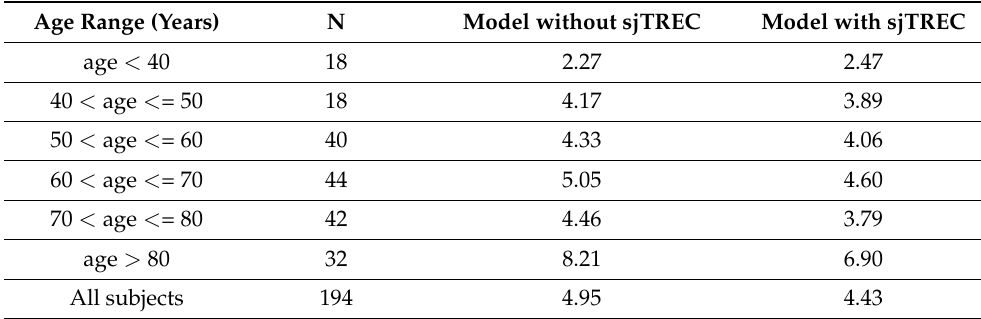
Table 4. Mean absolute error (MAE) from chronological age obtained in six different age groups divided into 10-year